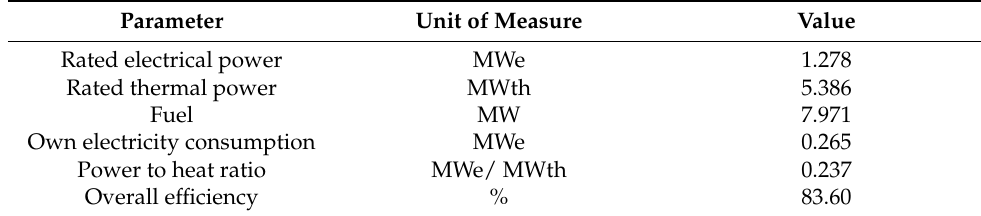
Table 2. Nominal technical characteristics of the CHP plant.